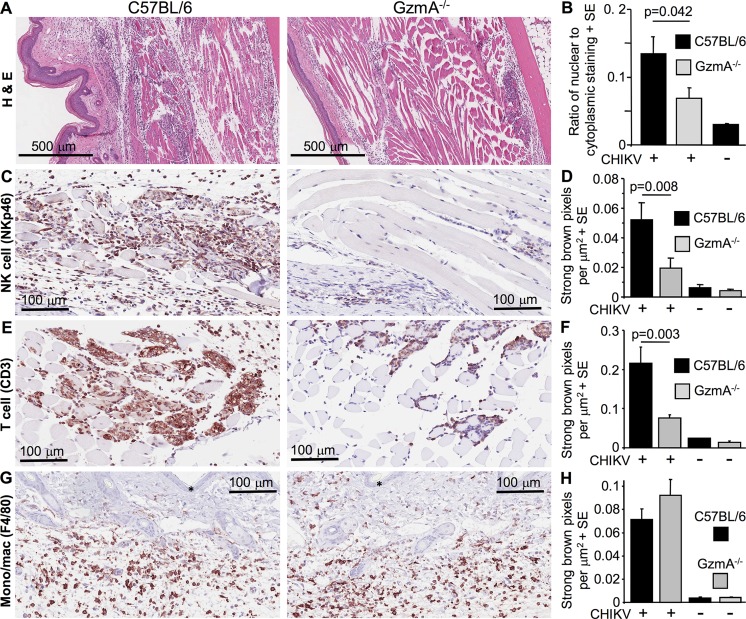
Histology and immunohistochemistry of GzmA-/- mice feet.(A) H&E staining of feet on day 6 post infection in C57BL/6 and GzmA-/- mice. Cellular infiltrates are characterized by high densities of blue staining nuclei; areas with pronounced cellular infiltrates are indicated by white oval outlines. (B) Aperio Positive Pixel Count determination of the ratio of blue (nuclear) to red (cytoplasmic) staining areas in whole foot sections day 6 post infection. Leukocytes tend to have a higher nuclear/cytoplasmic area ratio, so elevated ratios reflect increased leukocyte infiltrates [13]; (n = 6 feet from 6 mice per group, 3 sections per foot; statistics by 2 way ANOVA including a term for section). (C) Immunohistochemical staining for NK cells (anti-CD335/NKp46) clearly visible (brown staining) in muscle tissue of feet from CHIKV-infected C57BL/6 mice 6 days post infection (left). NK cell staining was less pronounced in GzmA-/- mice (right). Blue counter staining with haematoxylin. (D) Aperio Positive Pixel Count determination of NK cell staining; strong brown pixels per μm2 in whole feet sections (3 sections per foot; n = 11–12 feet from 11–12 mice per group from 2 independent experiments. Statistics by Mann Whitney U test). (E) As for C for T cell (anti-CD3) staining. (F) As for D for T cell staining. Statistics by Kolmogrov Smirnov test. (G) As for C for monocyte/macrophage (F4/80) staining, which was prominent in subcutaneous tissues (* indicates epidermis). (H) As for D for monocyte/macrophage staining.